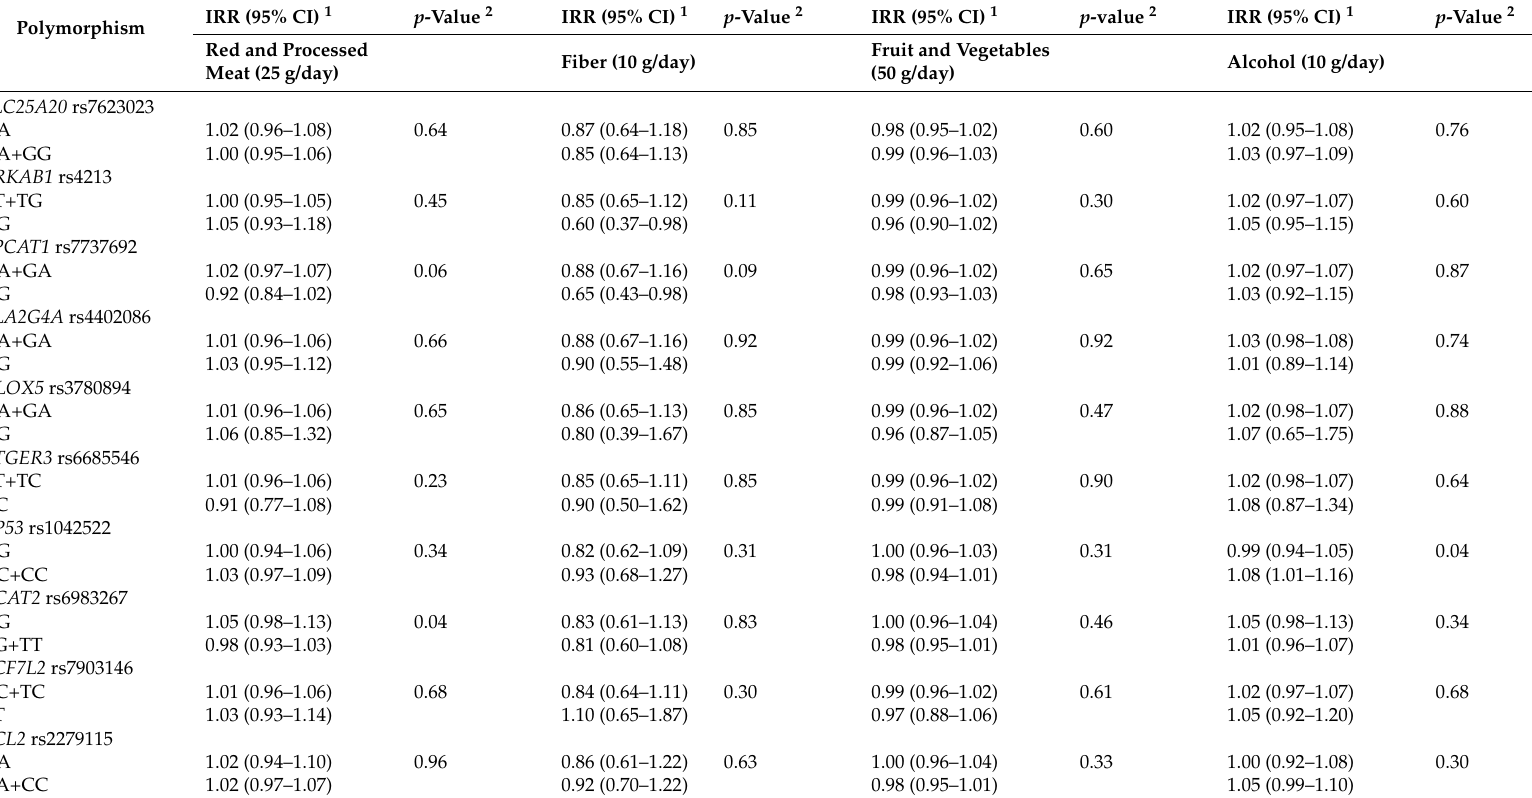
Table 4. Interactions between polymorphisms and dietary